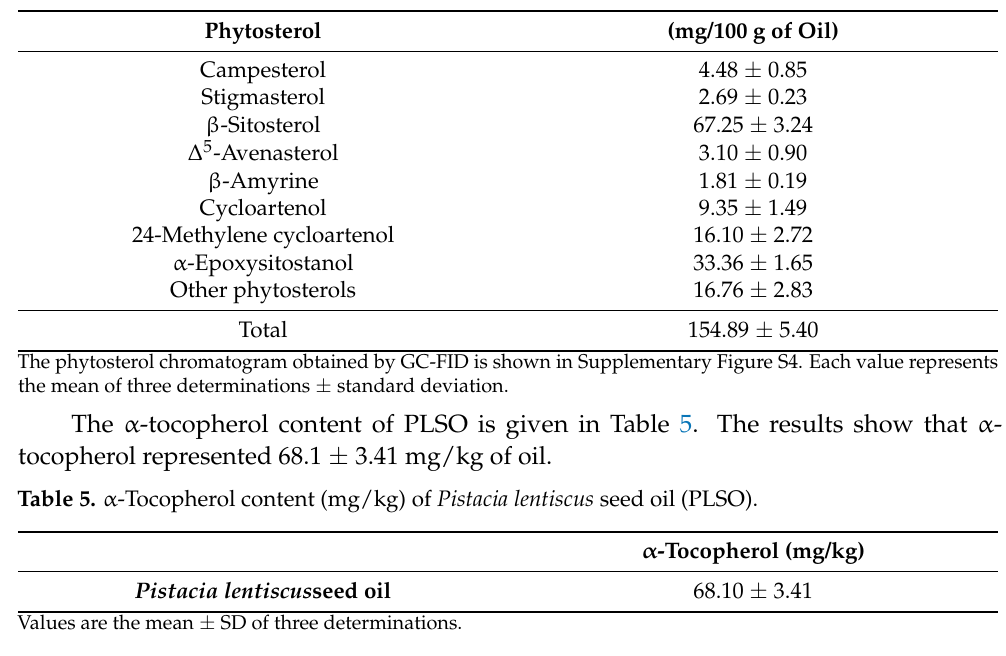
Table 4. Pistacia lentiscus seed oil phytosterol profile (mg/100 g of oil).